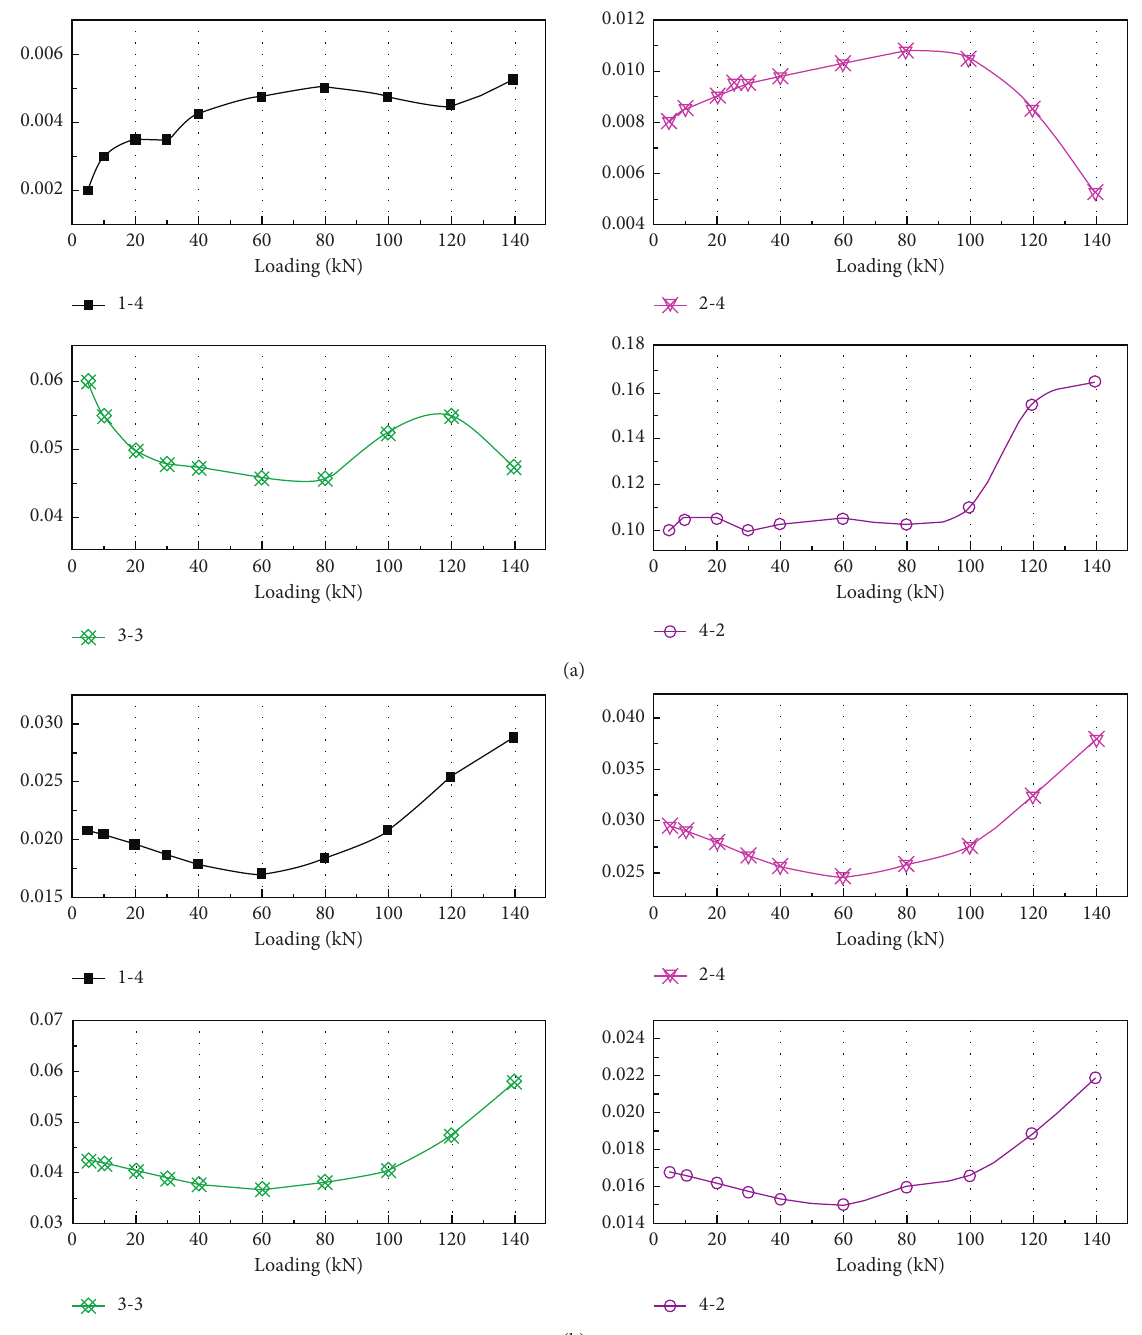
Figure 8: Slopes of stress curves in the transfer zone (take monitoring points 1-4, 3-3, 2-4, and 4-2 as an example). (a) Vertical and (b)